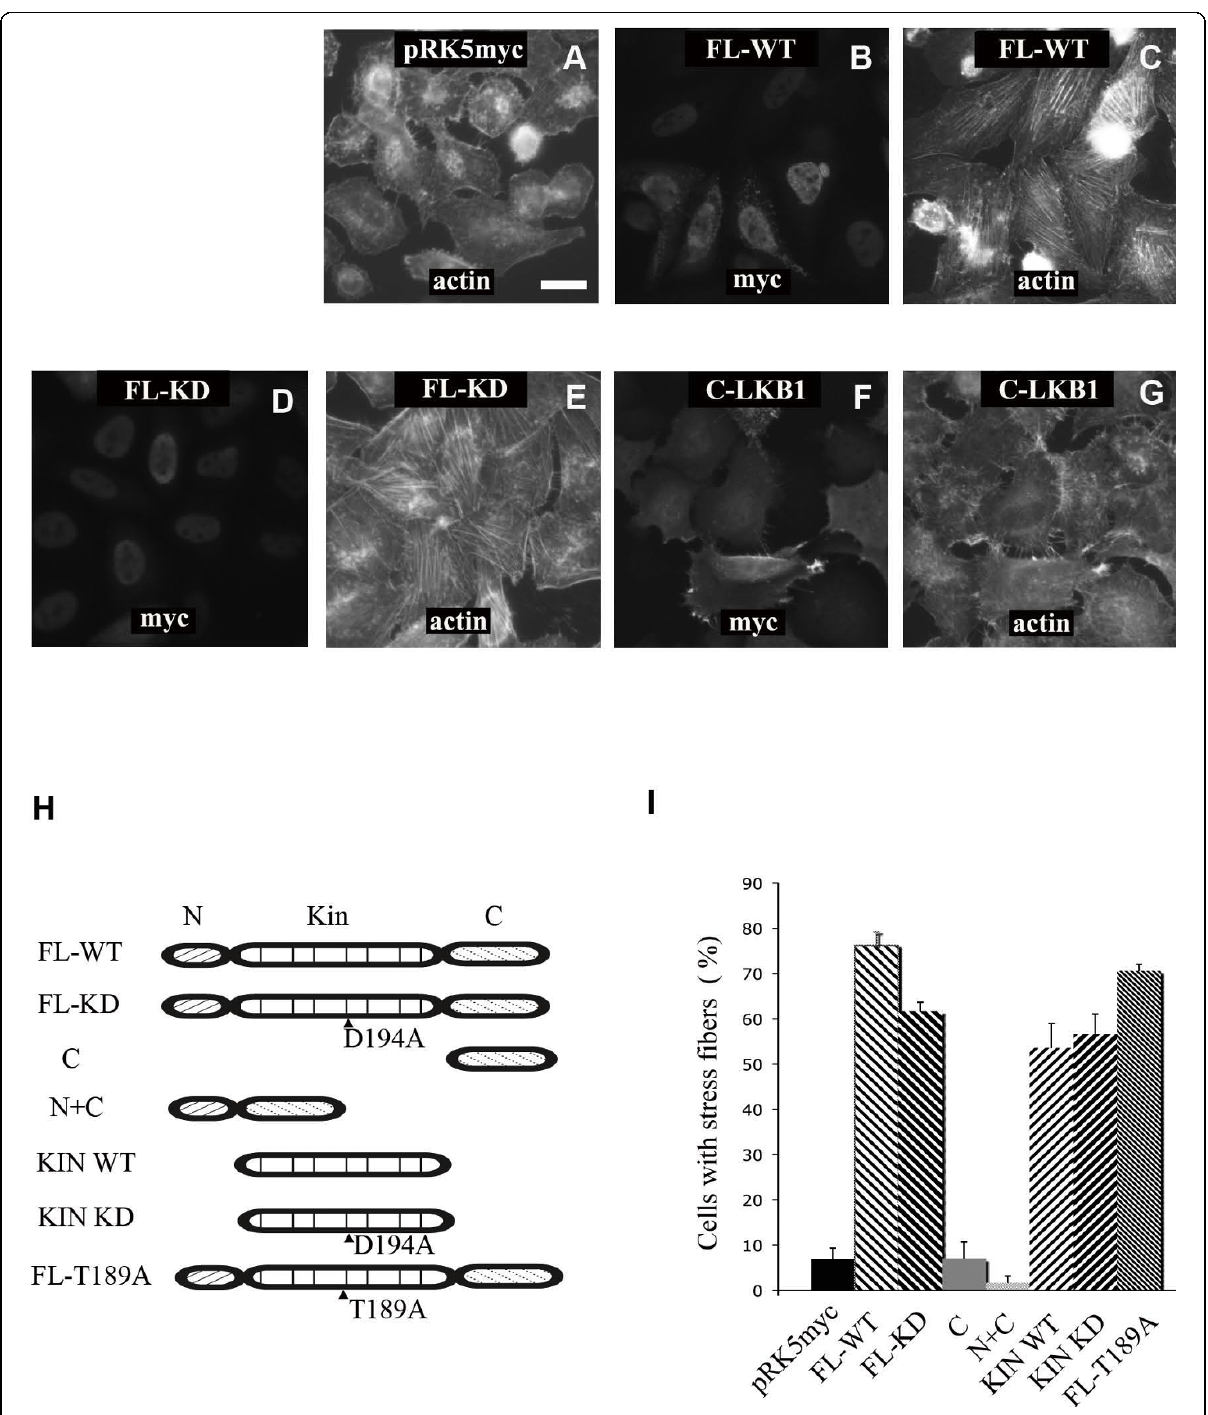
Figure 1 LKB1 expression induces actin filament assembly in HeLa-S3 cells . HeLa-S3 cells were transfected with different myc-tagged LKB1 constructs cloned into the pRK5 expression plasmid. Cells were fixed and stained with anti-myc antibody and fluorescent phalloidin to visualize filamentous actin. A . Control cells expressing an empty pRK5-myc vector displayed mainly cortical actin filaments and a few thin actin filaments across the cell bodies. B-E . Expression of wild type (B and C), or kinase dead (D194A) myc-tagged LKB1 (D and E) led to actin filament formation in HeLa-S3 cells. Both wild type and kinase dead LKB1 were found in the nucleus and in the cytoplasm. F, G . LKB1 C-terminus does not induce actin filaments. H . LKB1 domain structure and constructs used in the paper. Critical amino acids are indicated. I . Quantification of LKB1 effect on actin filament (stress fiber) formation. Expressing cells were scored for stress fiber formation (actin filament bundles across cell bodies). Scale bar = 20 μ